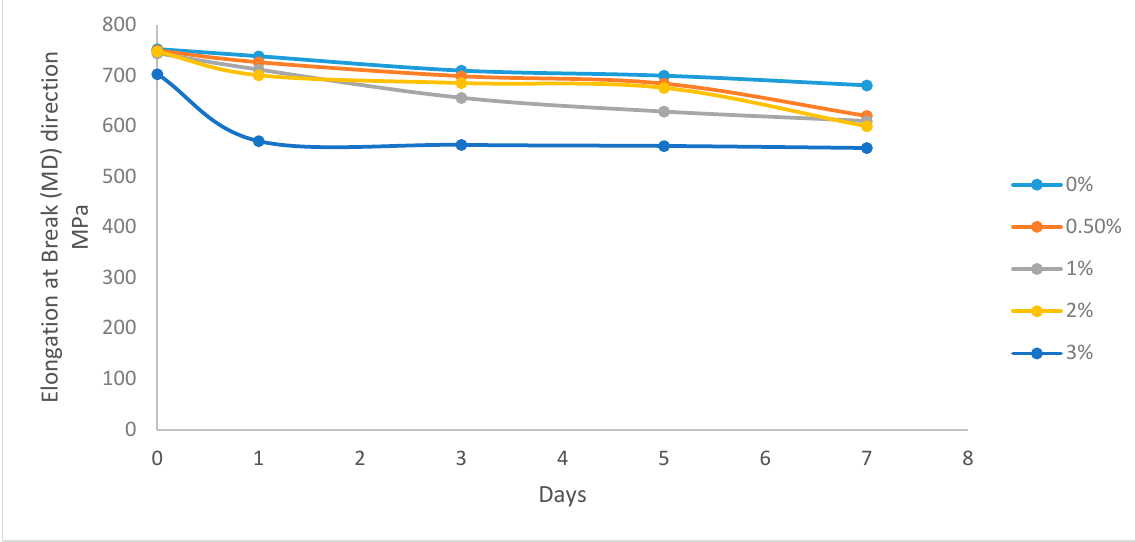
Figure 5. Changes in elongation at break in machine direction (MD).